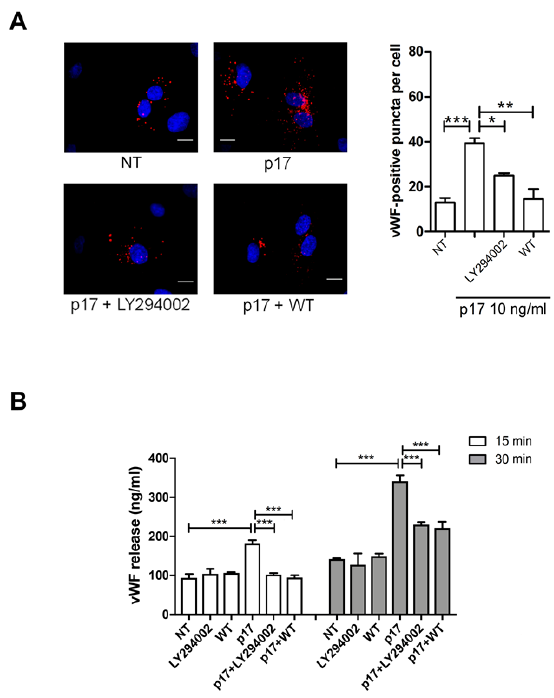
Figure 6. Role of PI3K in p17-induced vWF secretion. ( A ) HUVECs were nucleofected with a mCherry-vWF-expressing plasmid. Twenty-four h after nucleofection, cells were serum starved for 16 h and then treated for 1 h with the PI3K inhibitor LY294002 (10 μM) or wortmannin (WT [100 nM]) before stimulation with p17 (10 ng/mL). The images display vWF signals in red and cell nuclei in blue. Scale bar, 10 μm. Red-positive punctate structures were counted in order to quantify the levels of WPBs. NT indicates not treated cells. Values reported for vWF positive structures are the mean ± SD of 3 independent experiments with similar results. Statistical analysis was performed by one-way ANOVA, and the Bonferroni post-test was used to compare data (* p < 0.05, ** p < 0.01, *** p < 0.001). ( B ) HUVECs were serum starved for 16 h. After serum starvation, cells were treated or not for 1 h with the PI3K inhibitor LY294002 (10 μM) or wortmannin (WT [100 nM]) before stimulation or not with 10 ng/mL of p17. Supernatants were collected at 15 and 30 min of culture and analyzed for the presence of vWF by a standard quantitative ELISA. Bars represent the mean ± SD of triplicate samples. Statistical analysis was performed by one-way ANOVA, and Bonferroni post-test was used to compare data (*** p < 0.001). NT indicates not treated